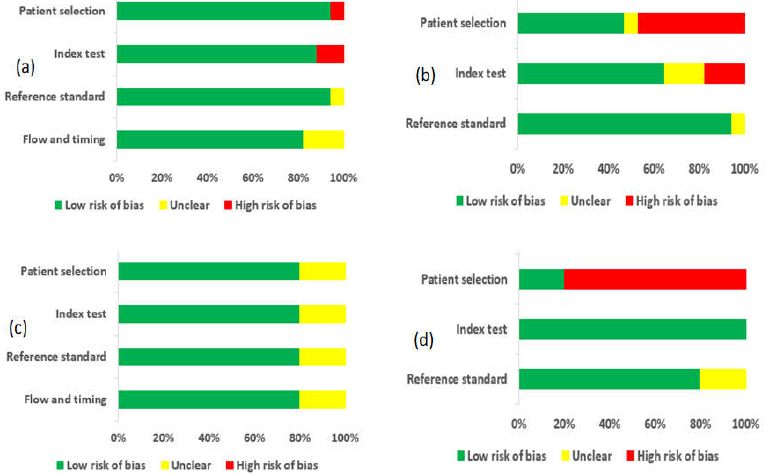
Figure 3. Risk of bias and applicability concerns expressed as percentages across all included studies. ( a ) Risk of bias for DBT; ( b ) Applicability concerns for DBT; ( c ) Risk of bias for CBBCT; ( d ) Applicability concerns for CBBCT.